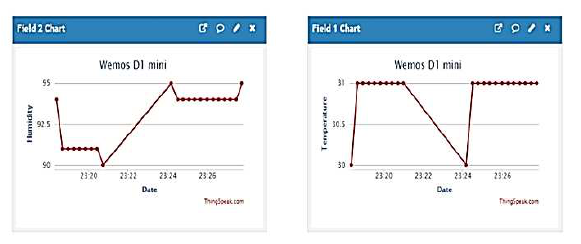
Figure.4. Sensor output on Thinkspeak